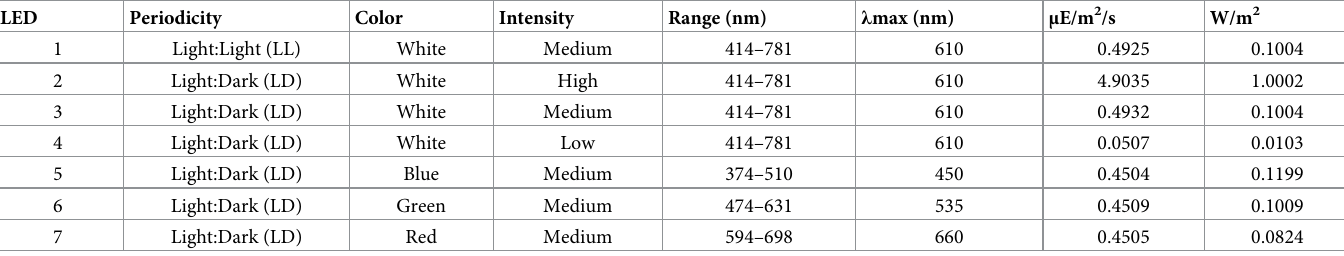
Table 1. Properties of the light-emitting diodes (LEDs). The intensities of the LEDs were adjusted by measurements by a spectroradiometer. For the white light, three intensities were used high (1.0 W/m 2 ), medium (0.1 W/m 2 ) and low (0.01 W/m 2 ) and the photon flux was adjusted, accordingly. For different spectral experiments, green was set as 0.1 W/m 2 and blue and red were adjusted to the same photon flux. ( μ E/m 2 /s = μ mol/m 2 /s).